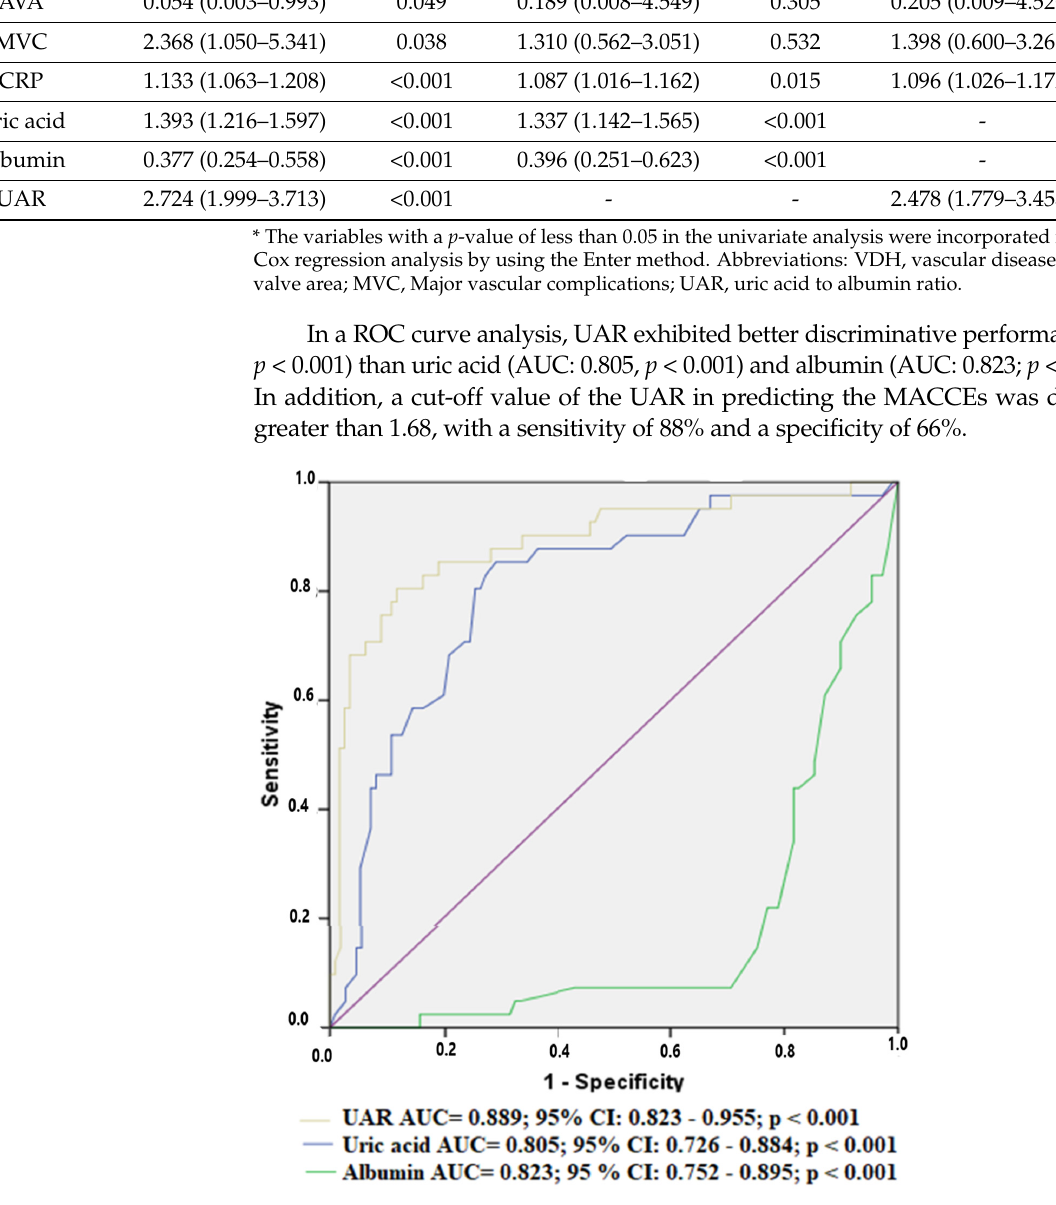
Figure 1. Discriminatory performances of UAR, uric acid and albumin for MACCEs.ROC Curve.